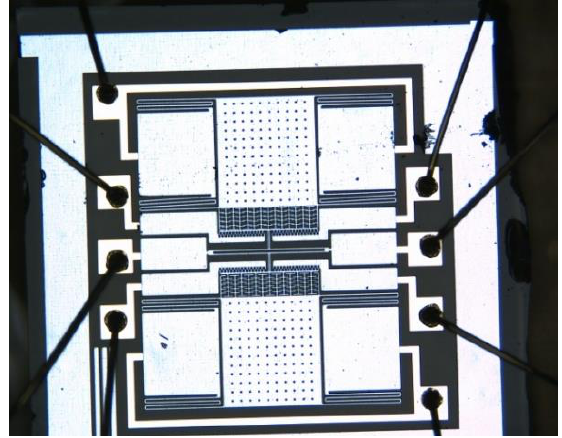
Figure 23. Deformation of double-stage folded beam.